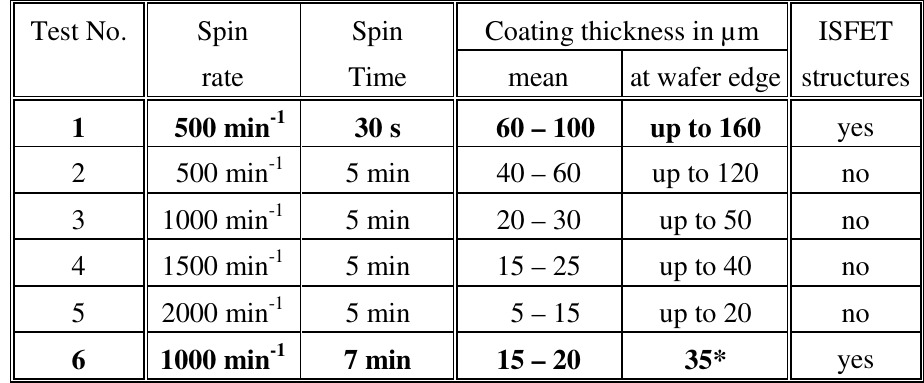
Table 3. Dependence of the thickness of deposited polyHEMA coatings on spin rate and time. Volume of liquid HEMA mixture dropped on the wafer – 2 ml. Time from the end of spinning to the beginning of irradiation – 5 min. Exposure time in nitrogen atmosphere – 5 min. Test